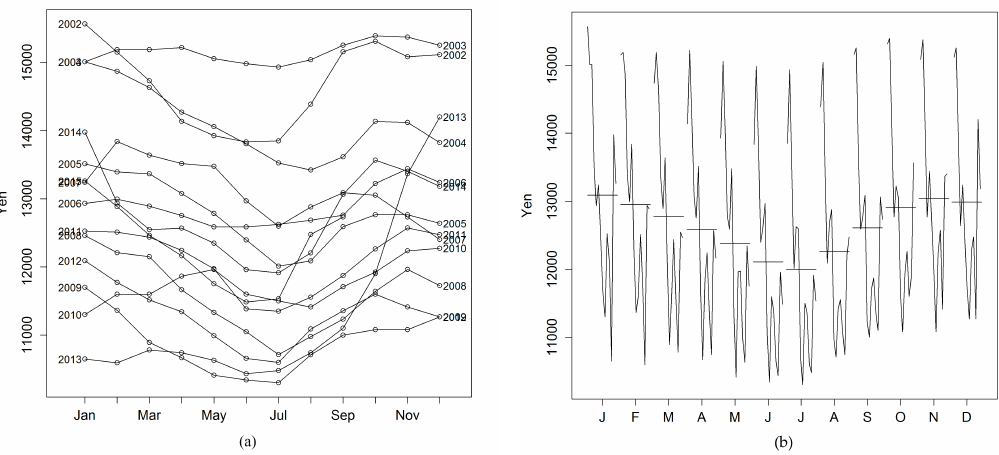
Figure 2. Annual and monthly sugi log prices: ( a ) Annual changes of sugi log prices against months; ( b ) monthly subseries of sugi log prices. In Figure 2b, the horizontal bars show the mean prices for the monthly subseries, and polygonal lines show the changes over the years from 2002 to 2015.